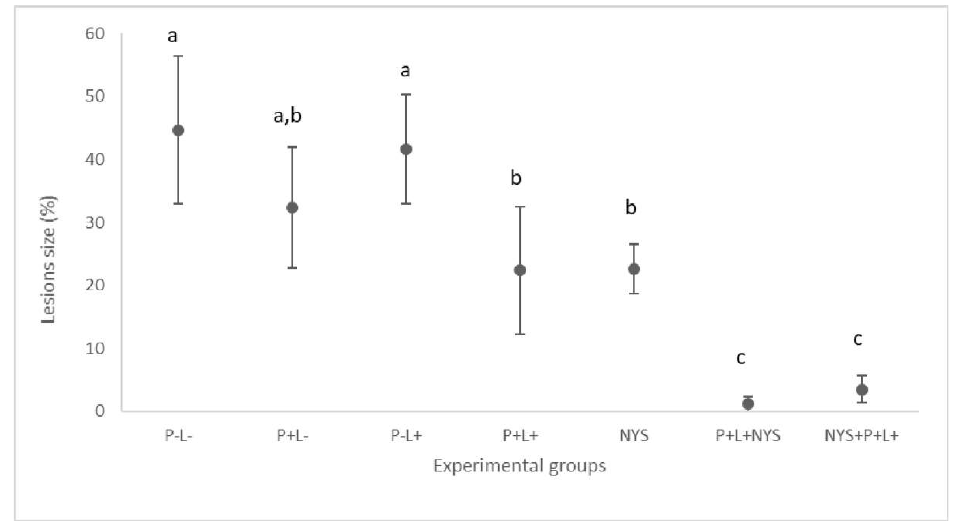
Figure 2. Mean values and standard deviation in percentages (%) of the lesion size (with the size of the patches) on the dorsum of the tongues of all the evaluated animals after 24 h of treatment. The letters a, b and c denote statistical differences between the groups ( p ≤ 0.05).